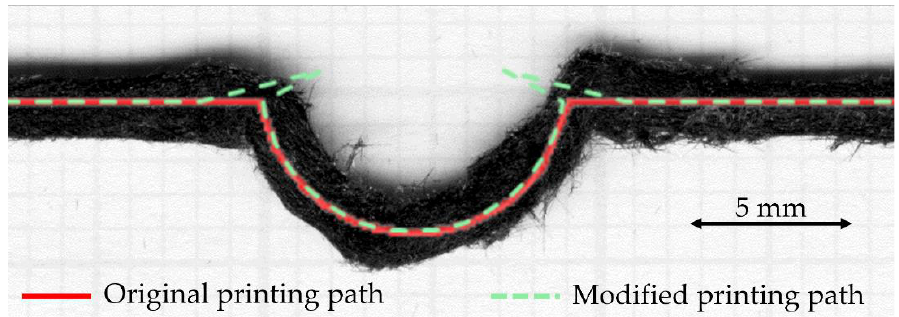
Figure 17. Curvilinear printing for open hole sample with a compensated printing path by moving further inward to the circular section before leaving back to the defined path.